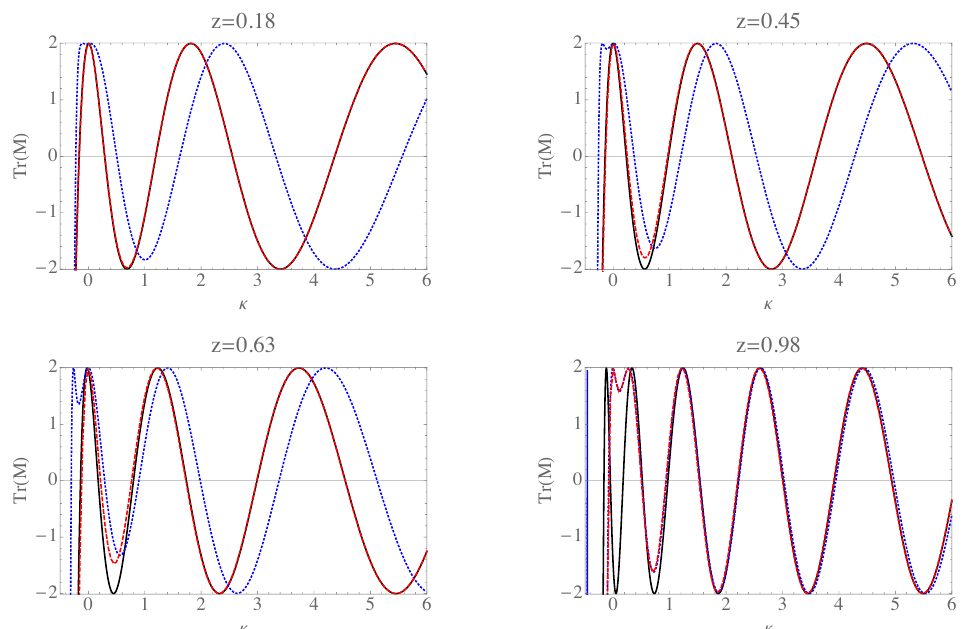
Figure 9 . Comparisons of analytic approximations to Tr( M ) with numerical results. Black, solid : the large (cid:20) and/or small z approximation (3.1). Blue, dotted : the z 1 approximation (2.33). Red, (cid:24) dashed : exact numeric result. Parameters are (cid:11) L = 0 : 99 ; (cid:11) H = i . One can see the exact numerical solution transition between the z 0 and z 1 approximations in the series of (cid:24) (cid:24)